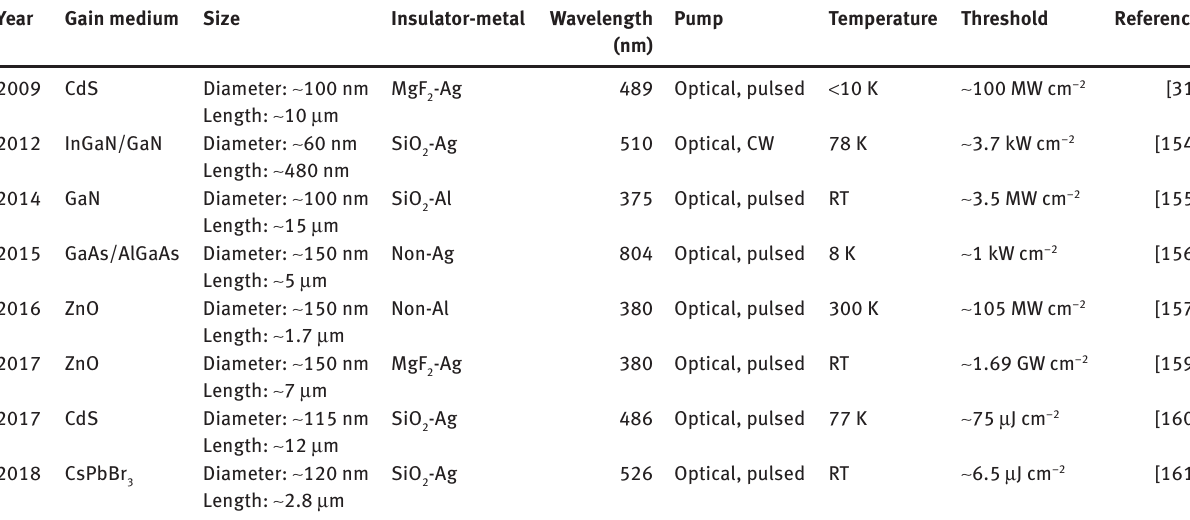
Table 1: Key metrics of representative plasmonic NW